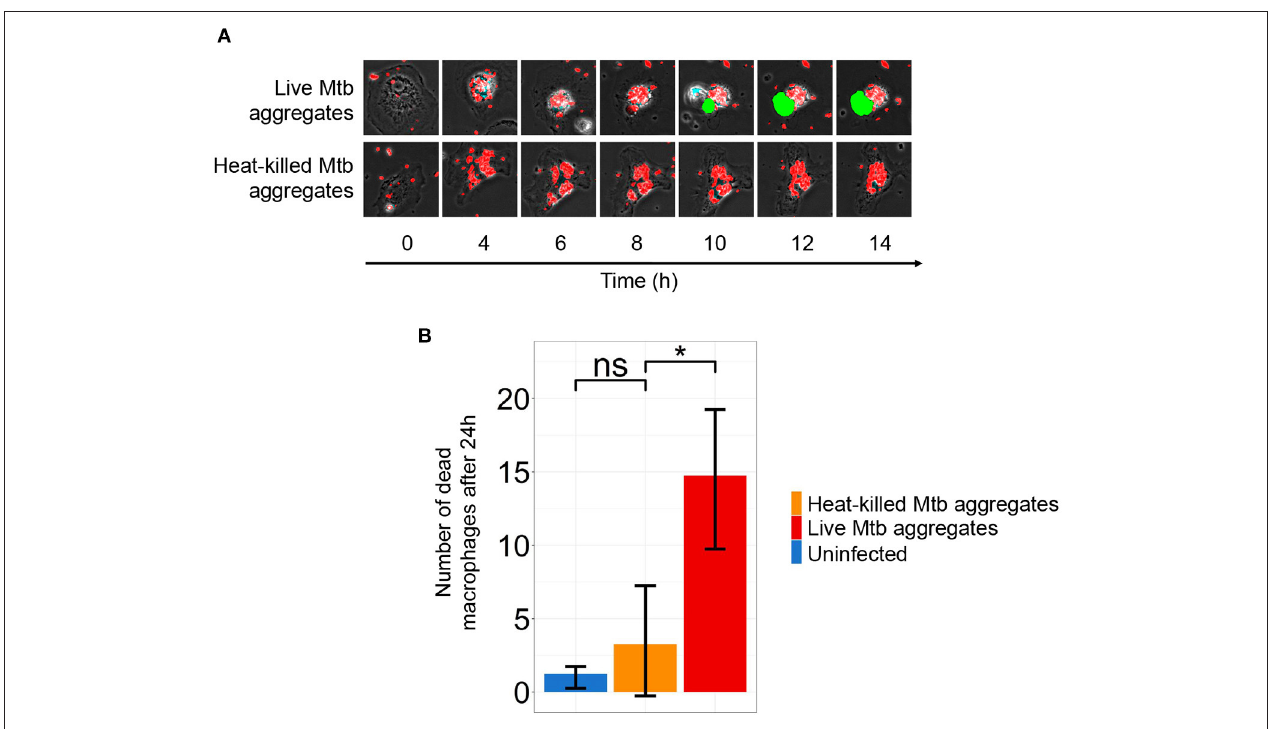
FIGURE 4 | Macrophage death is dependent on infection with live Mycobacterium tuberculosis (Mtb) aggregates. (A) Timelapse microscopy showing mCherry labeled Mtb (red) induced monocyte-derived macrophage (MDM) death as detected by DRAQ7 (green). (B) The number of dead cells in MDM infected with live Mtb (red bar), heat-killed Mtb (orange bar), or uninfected (blue bar) after 24 h. Shown are mean ± SD of DRAQ7 positive cells after 24 h. p -values are ns = not significant and * <